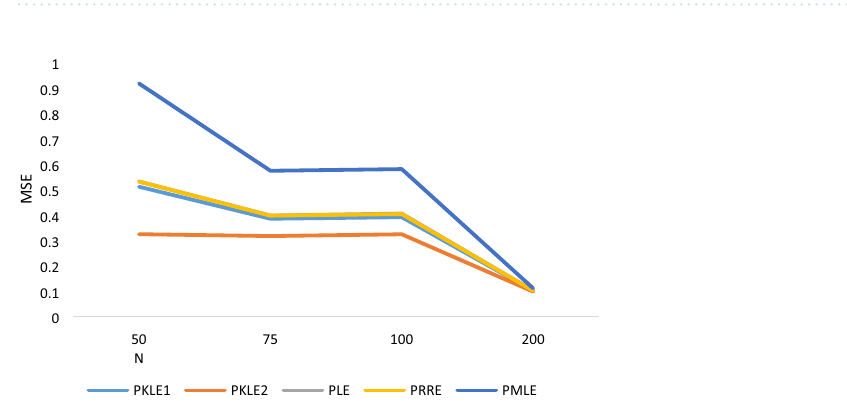
Figure 2. Intercept = 0; ρ = 0.99; p = 4.